Question: Is the quantity shown trending increasing or decreasing?
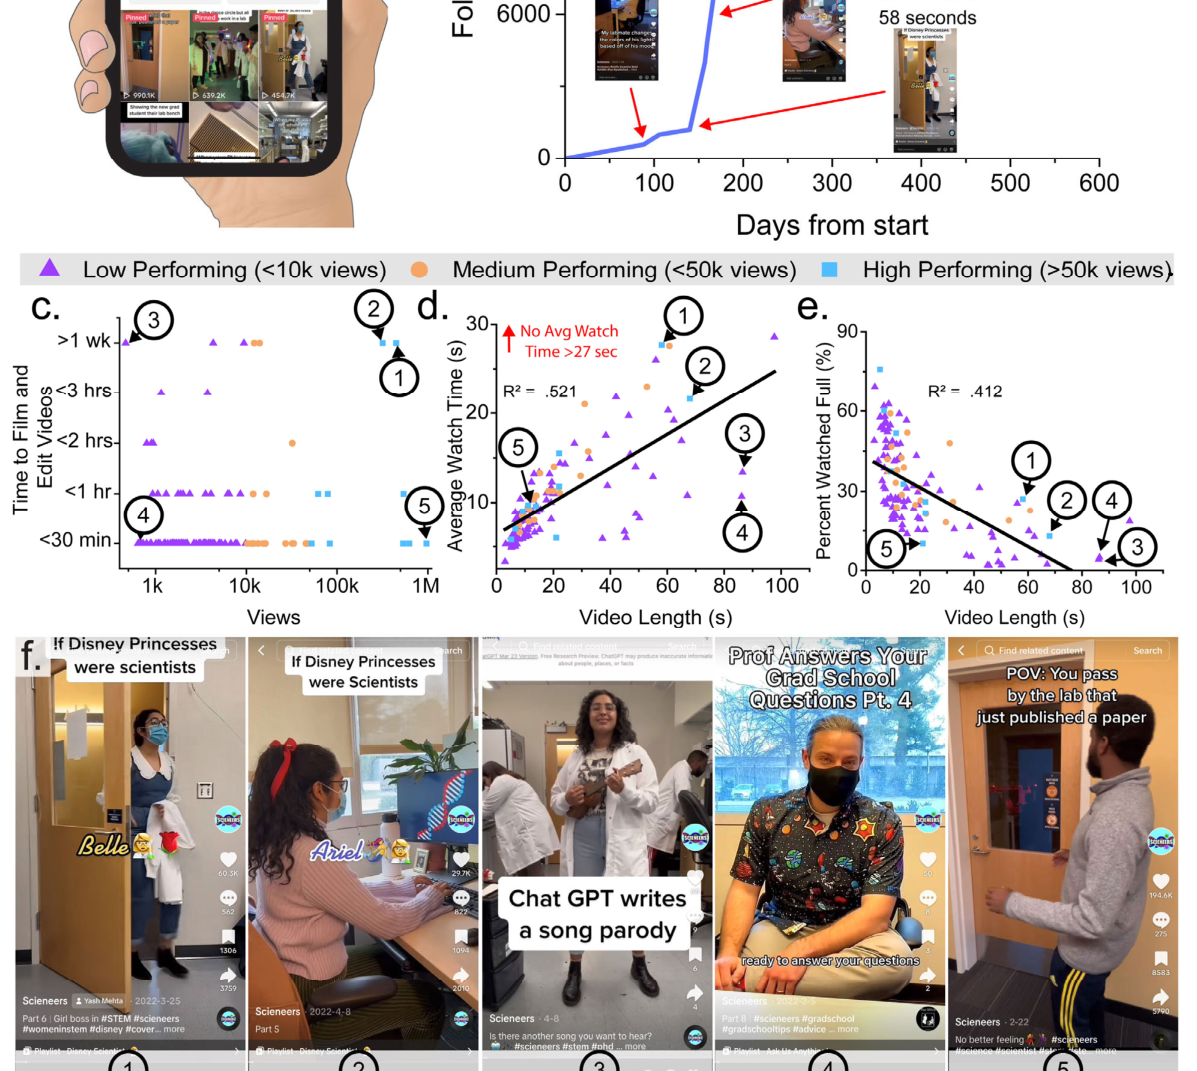
Answer: increasing